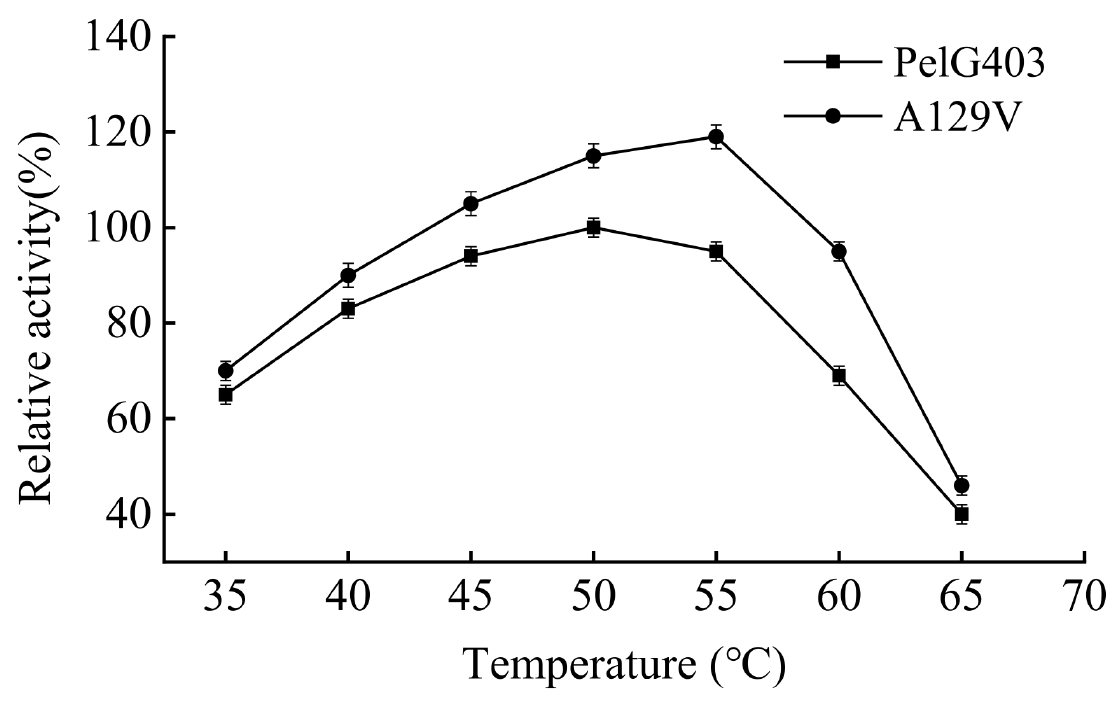
Figure 4. Optimal temperature of PelG403 and A129V. The wild-type PelG403 has the highest activity at 50 ◦ C. A129V has the highest activity at 55 ◦ C. The highest activity of the wild-type PelG403 is considered to be 100%. Values are the means ± SD of three replicates.